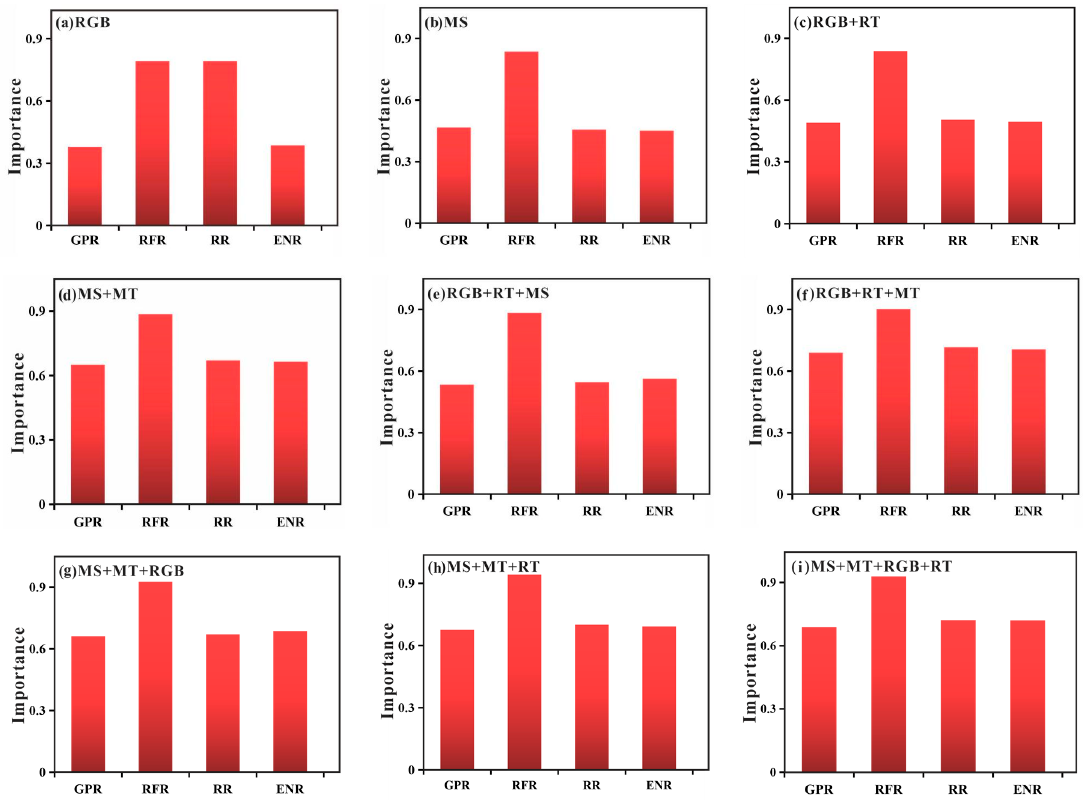
Figure 5. Statistical distribution of the prediction accuracy of individual machine learning models and ensemble learning models constructed based on spectral and texture features of UAV RGB and multispectral. RT RGB Texture Features, MS Multi-spectral spectral features, MT Multi-spectral tex- ture features, ENR Elastic network regression, RFR Random Forest regression, GPR Gaussian pro- cess regression, RR Ridge Regression, Stacking (RR) stacking regression using ridge regression as a secondary learning model.